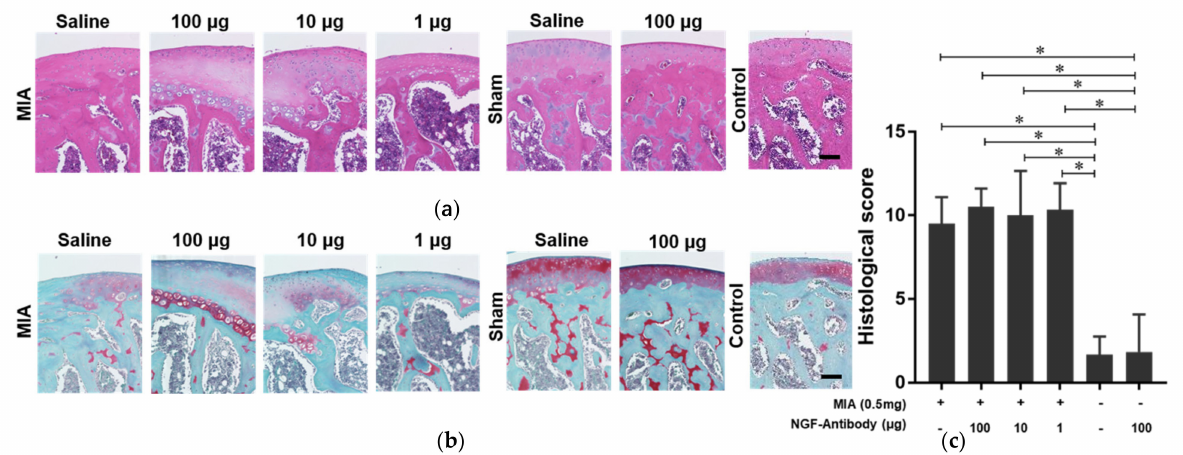
Figure 3. Histological evaluation of rat-affected knee joints consistent with macroscopic evaluation. ( a ) Hematoxylin and eosin (H&E) staining showed that the inflammation formed around the cartilage and chondrocytes was disorganized and no longer observed after MIA injection. The scale bar is 100 µ m. ( b ) Results of safranin O staining showed that MIA injection induced cartilage degradation, characterized with cartilage irregularities and reduction in staining intensity. The scale bar is 100 µ m. ( c ) The results of the Mankin score showed no significant difference among the MIA groups or between the sham groups, revealing that the treatment of the anti-NGF antibody did not exacerbate the pathological progression of OA joints. The results represent the 95% confidence intervals for six rats. * indicates a significant difference, as determined by one-way analysis of variance, followed by the Tukey’s multiple-comparison procedure ( p ≤ 0.05).